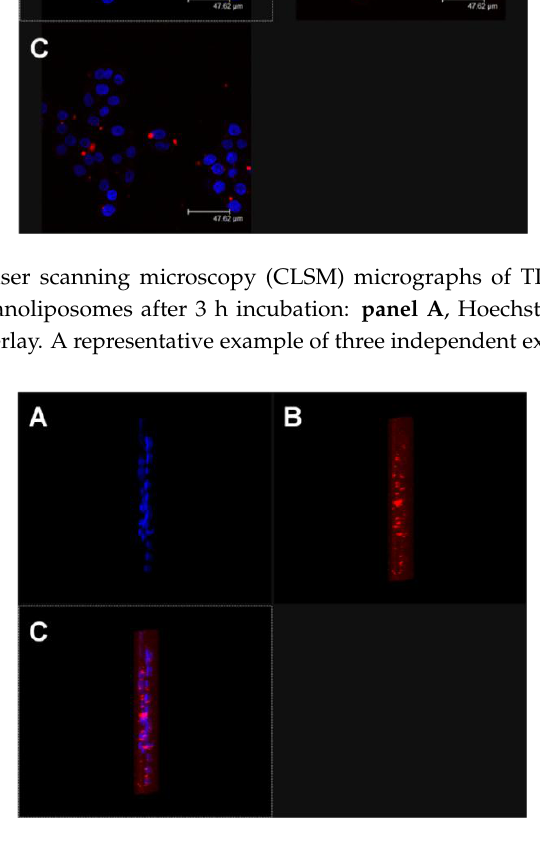
Figure 6. Z-stack analysis by CLSM of TPC-1 cells treated with rhodamine-labelled nanoliposomes after 3 h incubation: panel A , Hoechst filter; panel B , TRITC filter; and panel C , overlay. A representative example of three independent experiments.